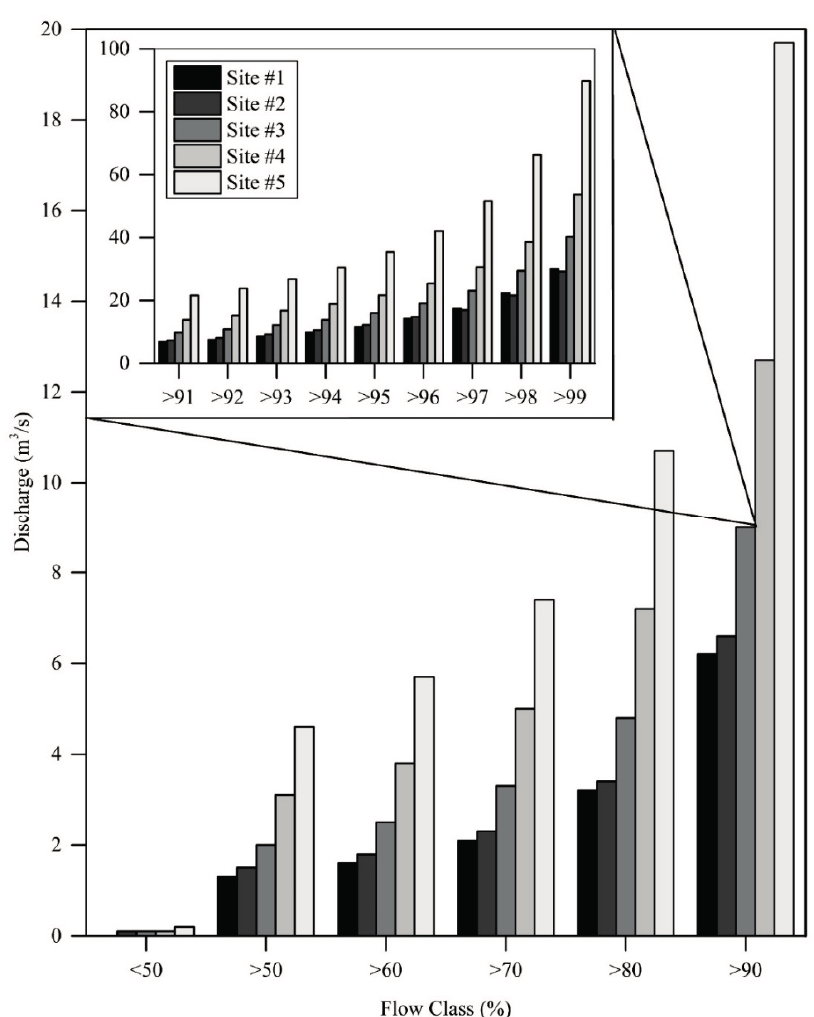
Figure 2. Mean discharge above and below median values for each gauging site (WY 2011 to 2012) in Hinkson Creek Watershed, USA. The nested plot expands the >90% flow class for a total of 15 flow